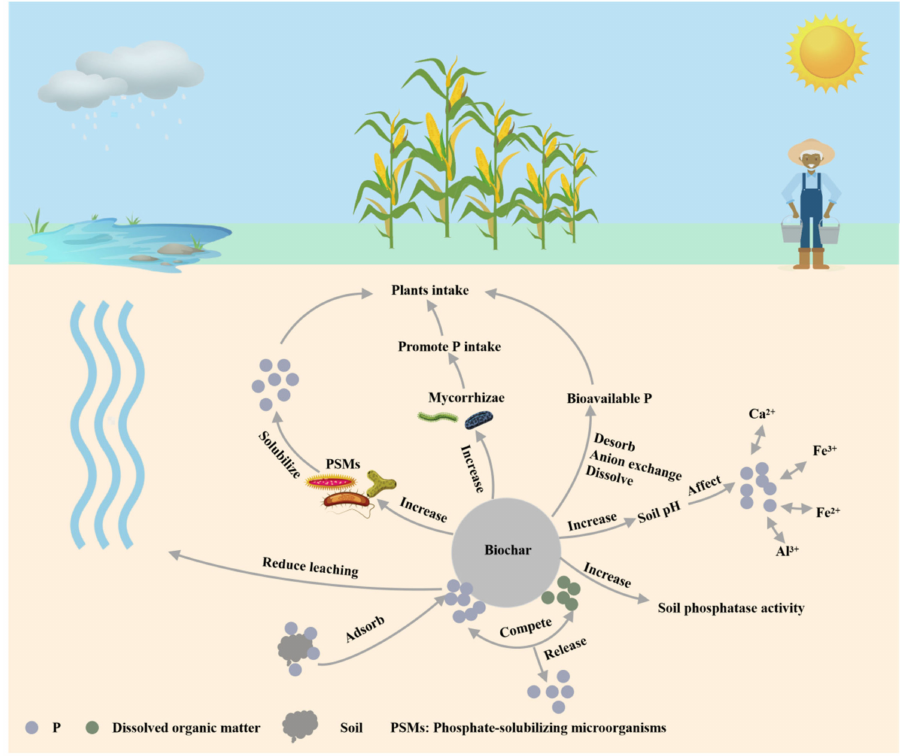
Figure 2. The mechanisms of biochar application on P improvement in soil